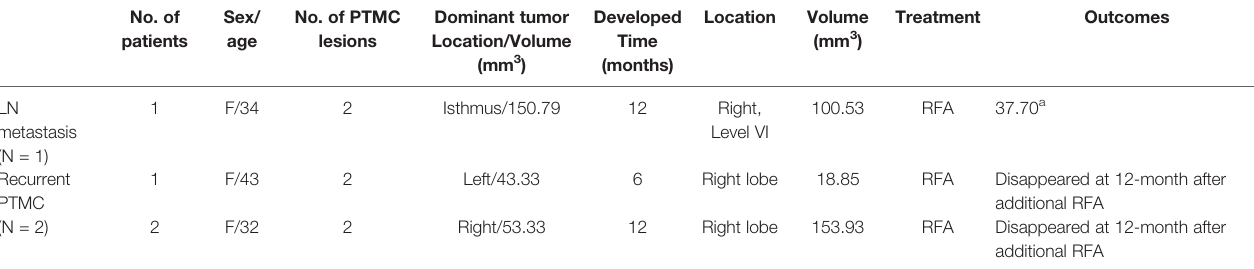
TABLE 3 | The clinical characteristics and outcomes of patients with local tumor